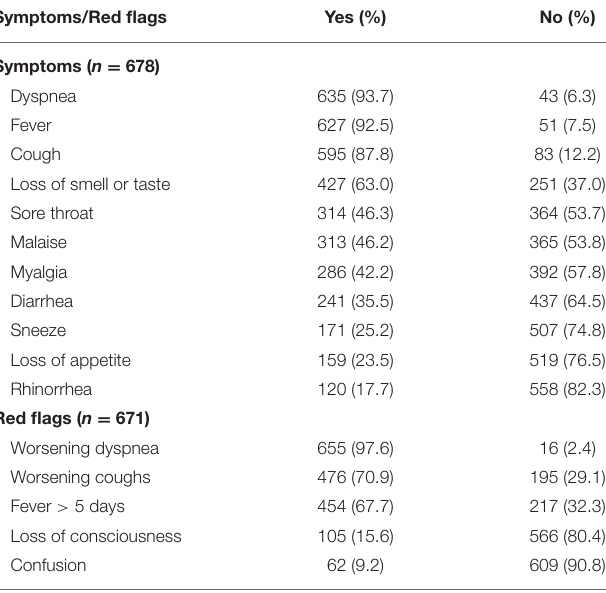
TABLE 2 | Students’ knowledge on symptoms of COVID-19 and red-flags of severe disease. Symptoms/Red